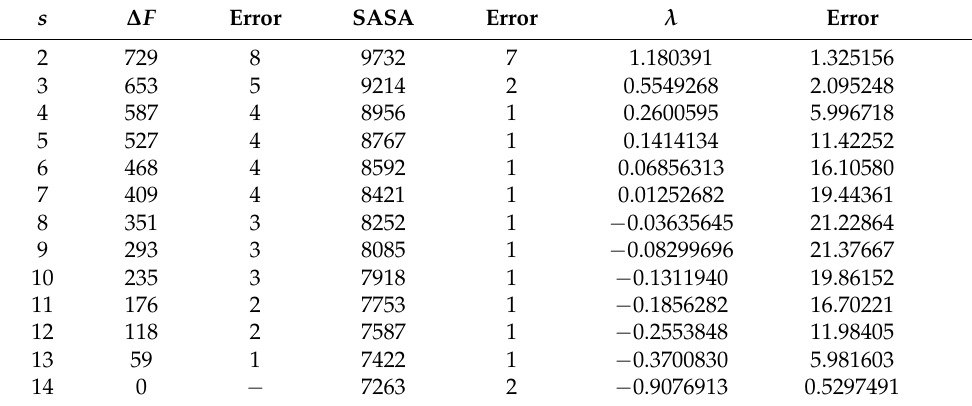
Table 5. Block average and error analysis on ∆ F (kcal/mol) (calculated at T = 400 K and Equation (12)) and on solvent-accessible surface area (SASA, Å 2 ). Data are for wild-type sequence. Last columns report λ and its